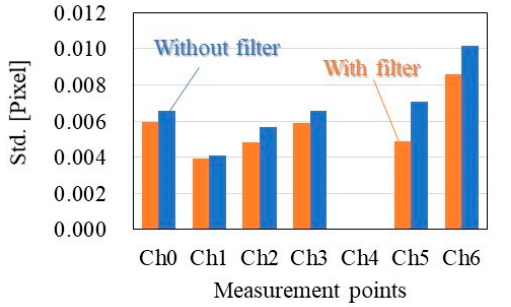
Figure 11. Measurement error and the effect of filtering (35 Hz excitation at the